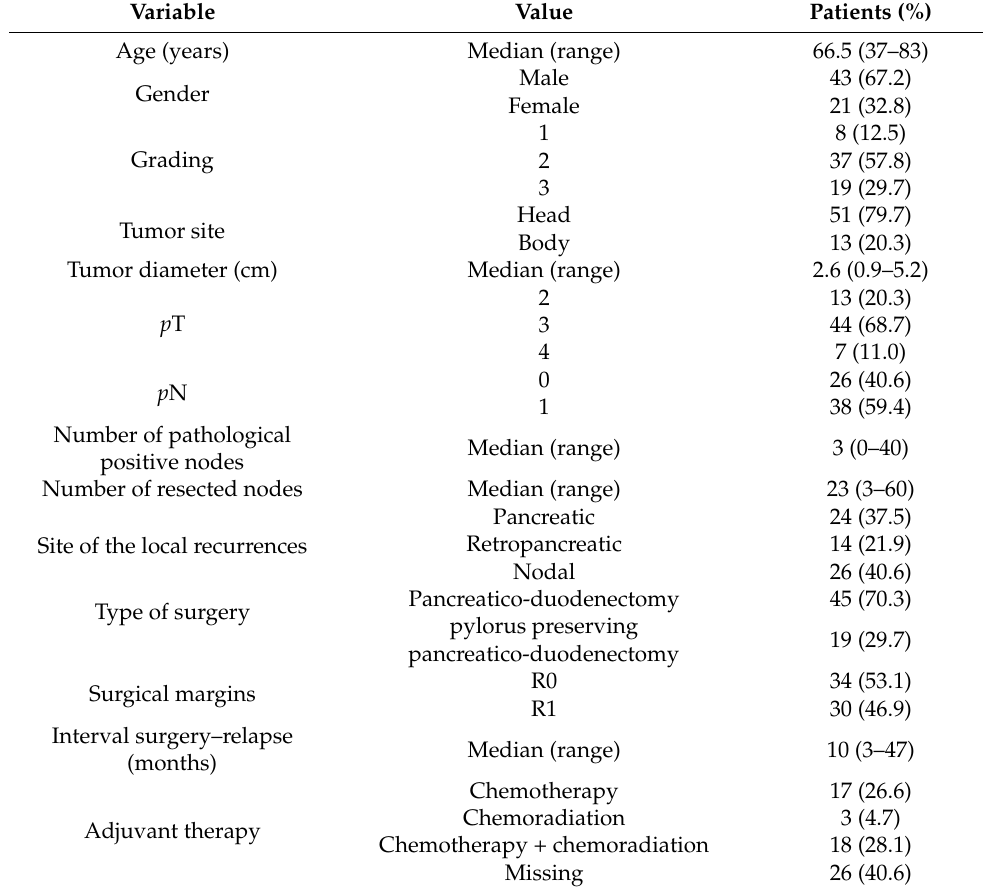
Table 1. Patients’